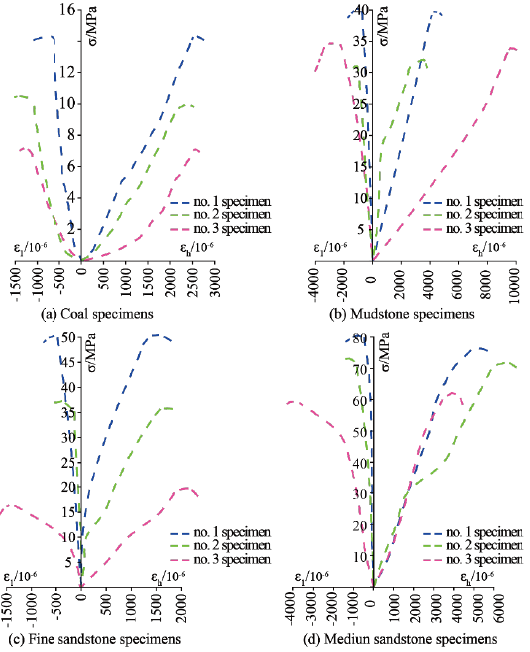
Figure 5. Stress – strain curves of rock specimens. Figure 5. Stress–strain curves of rock